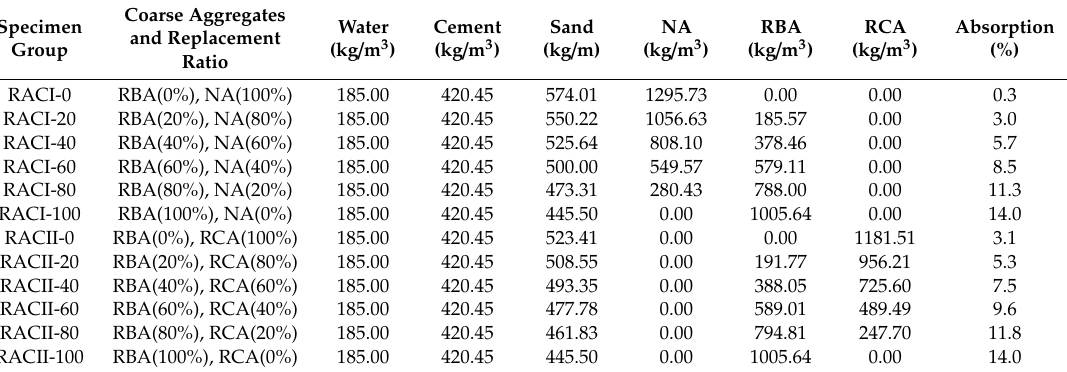
Table 2. Mix proportion design of RAC